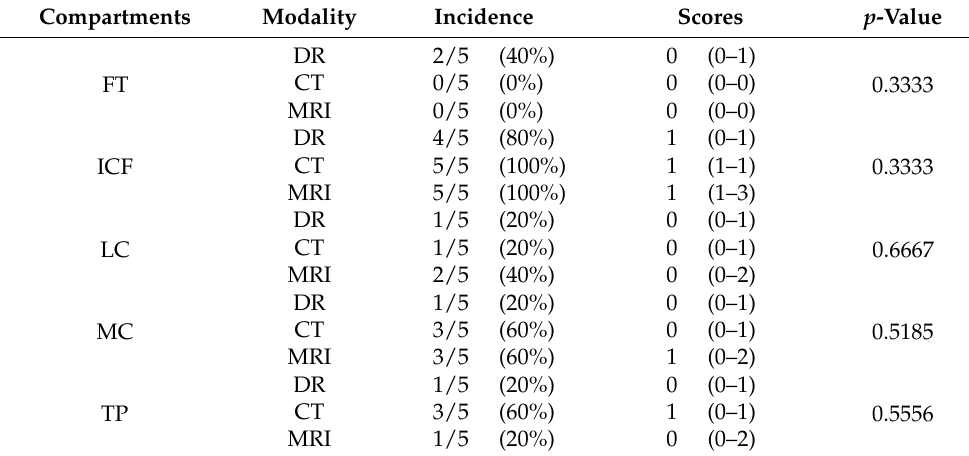
Table 4. Comparison of the subchondral bone lesions on DR, CT, and MRI images at different anatomic